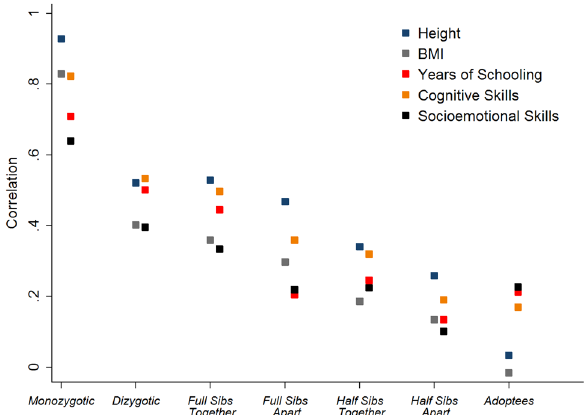
Swedish brother pairs born 1951 – 1970. All outcomes except years of schooling are measured at conscription, around the age of 18. For details on sample construction and variable de fi nitions, see chapter 3 in Cesarini. 10 The sample sizes vary by outcome, but the minimum number of pairs per sibling type is MZT = 1,154; DZT = 1,601; FST = 151,789; FSA = 1,033; HST = 4,880; HSA = 11,566; ADO = 643. Because the sample sizes are large, all correlation coef fi cients are precisely estimated. The standard error of a correlation coef fi cient estimated with N pairs of siblings is approximately ð 1 (cid:3) ^ ρ 2 Þ = example, the approximate standard error of the 72% estimate reported in the full text (full siblings reared apart)